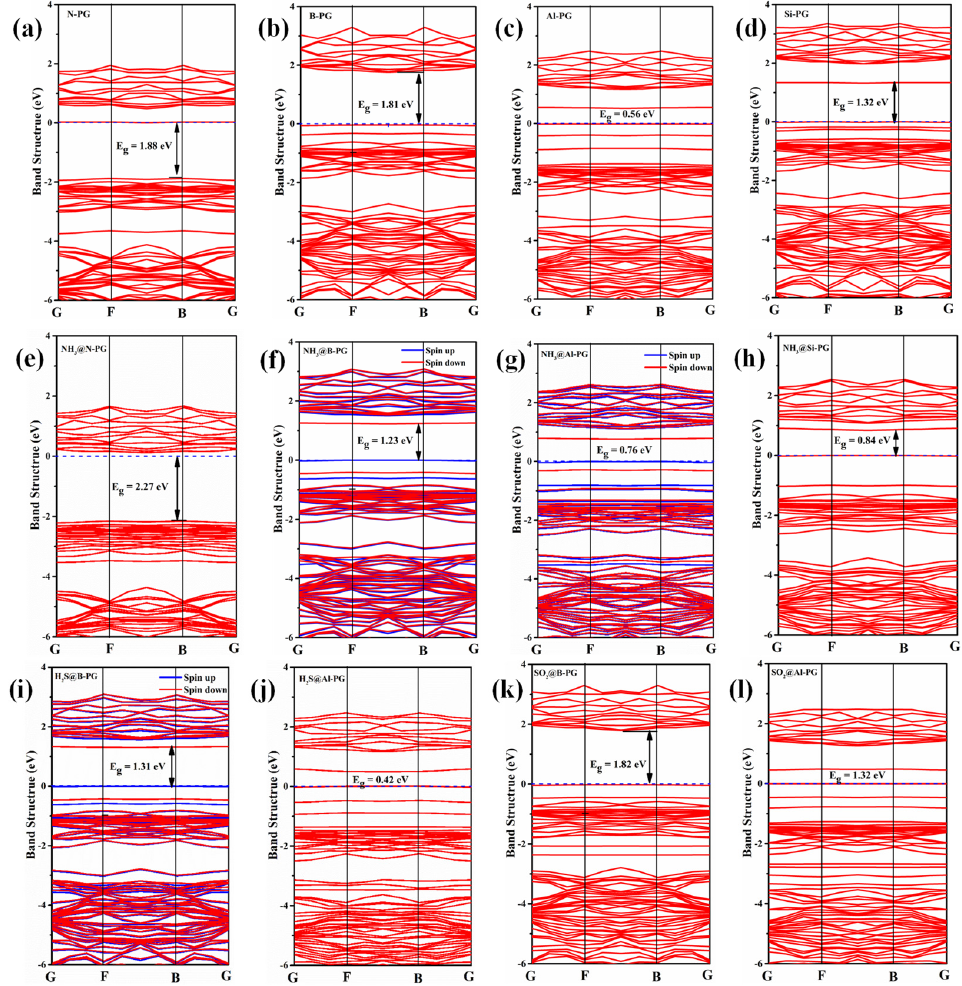
Figure 6. Band structures of the N-, B-, Al-, and Si-doped PG without gas adsorptions ( a – d ) and with NH 3 , H 2 S, and SO 2 adsorptions ( e – l ). The dashed lines are the Fermi level.